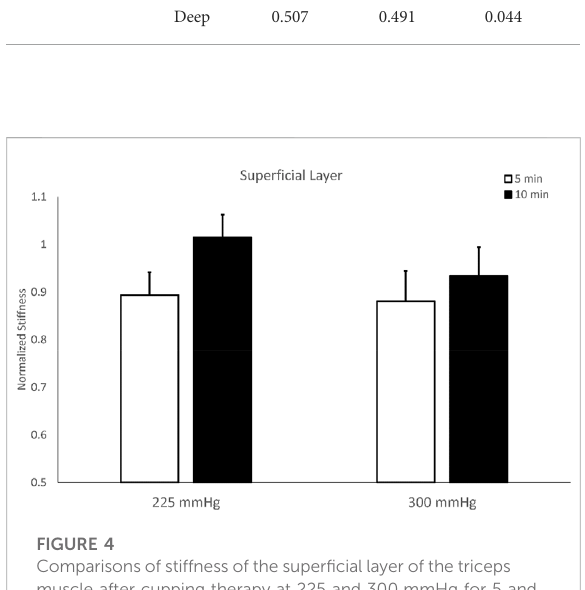
FIGURE 4 Comparisons of stiffness of the super fi cial layer of the triceps muscle after cupping therapy at 225 and 300 mmHg for 5 and 10 min. For the super fi cial layer, 5-min cupping appears more effective on reducing stiffness compared to 10-min